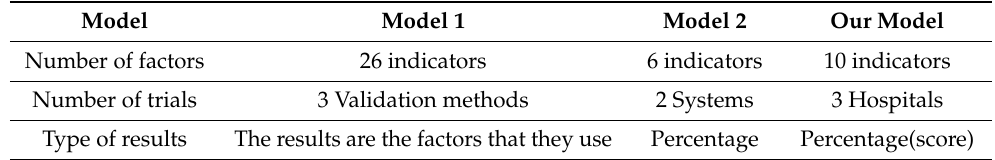
Table 4. Comparison between the two models from the literature and our